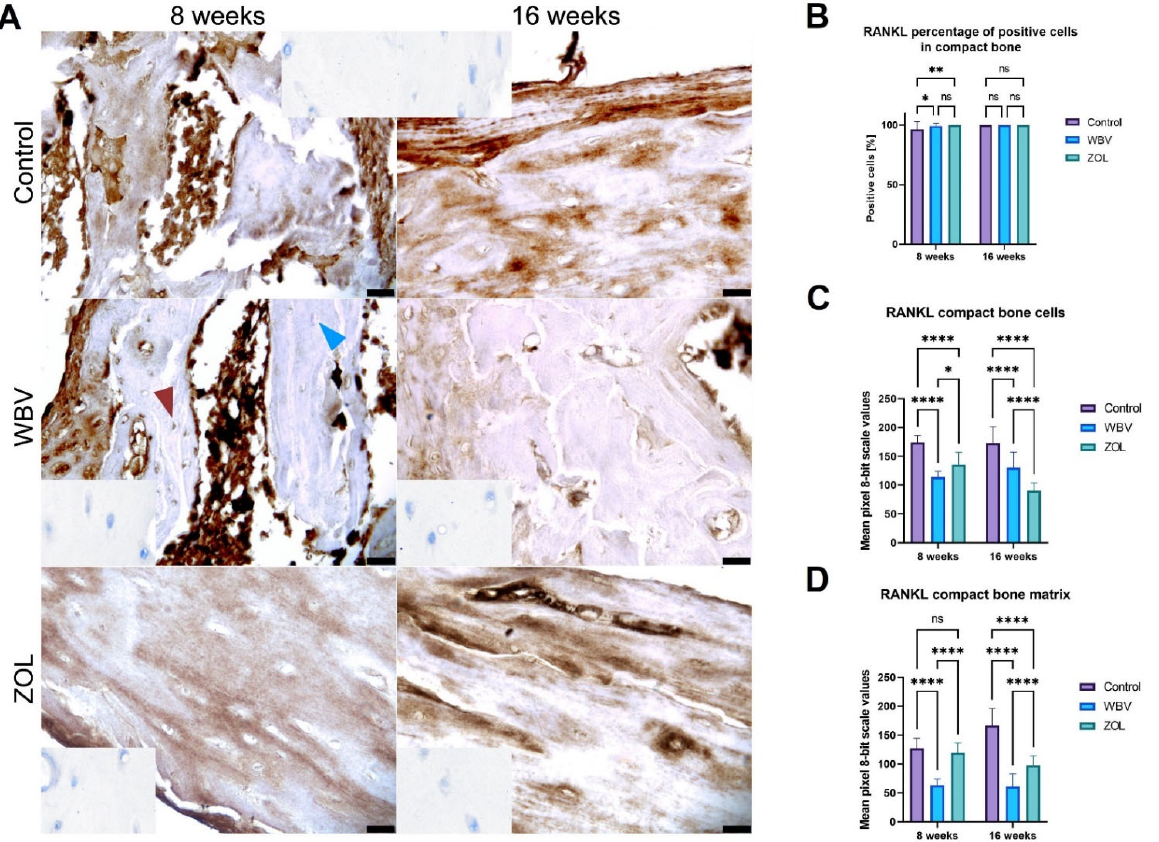
Figure 8. The immunohistochemical reaction for receptor activator for nuclear factor kappa ‐ B ligand (RANKL) in the compact bone of femora of rats subjected to obesity and immobility: ( A ) Representative images of the immunohistochemical reactions for RANKL. Brown and blue arrowheads indicate examples of positive and negative reaction cells, respectively. Insets show control immunohistochemical staining without primary antibody. All scale bars represent 50 μ m; bar graphs show the ( B ) the percentage of RANKL ‐ positive cells and the intensity of immunoexpression of RANKL ( C ) in cells (osteocytes), and ( D ) compact bone matrix measured by the 8 ‐ bit grayscale pixel brightness value (the higher the pixel value, the higher the intensity of the immunohistochemical reaction). Data are mean values ± SD (whiskers) from n = 6 rats. Control—the control group included rats subjected to obesity and immobility not treated with WBV or ZOL; WBV—the WBV group included rats subjected to obesity and immobility with whole-body vibration treatment (30 min, 5 days per week); ZOL—the ZOL group included rats subjected to obesity and immobility and injected intramuscularly with zoledronic acid at a dose of 0.025 mg/kg body weight every 4 weeks. Statistical significance: ns—not significant; * p < 0.05; ** p < 0.01; **** p < 0.0001 (Tukey’s HSD test or Kruskal–Wallis H